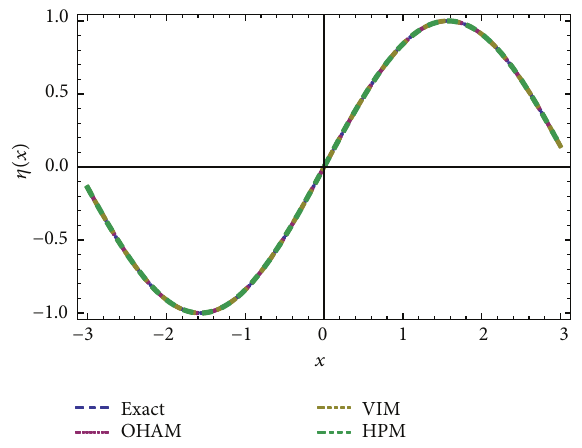
Figure 23: 2D, comparison of OHAM, VIM, HPM, and exact solutions for 𝜂(𝑥, 𝑡) at 𝑡 = 0.1 .